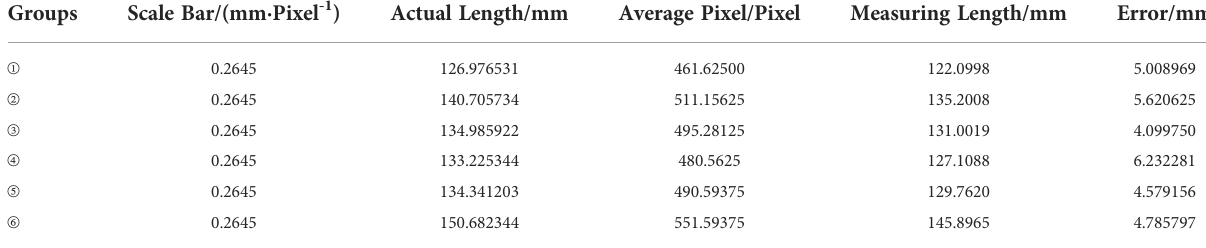
TABLE 8 Comparison of measurement results of leaf vein length. Groups